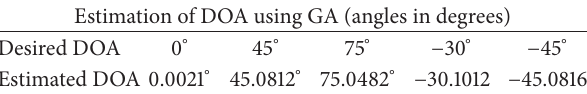
Table 2: Accuracy analysis of the target direction